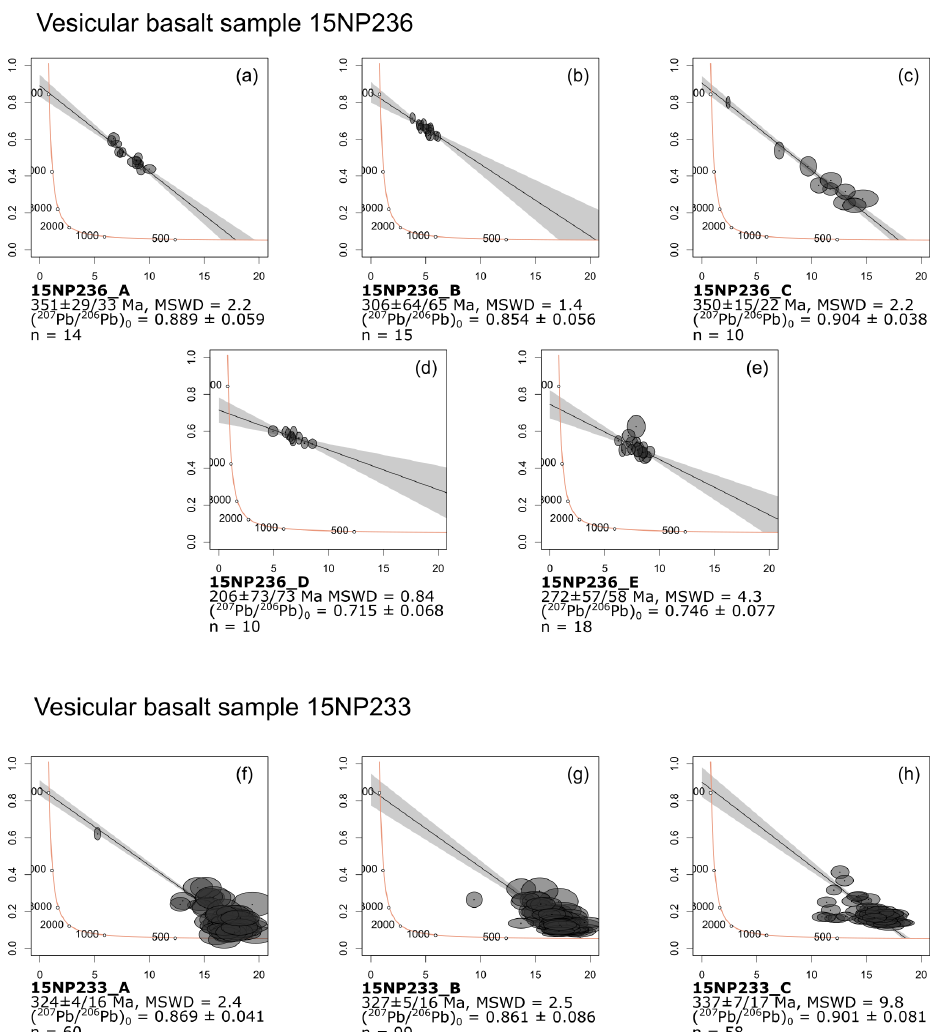
Figure 6. Tera–Wasserburg plots of ablation area ages on vesicular basalt samples 15NP236 and 15NP233. All errors are given as 2 σ .